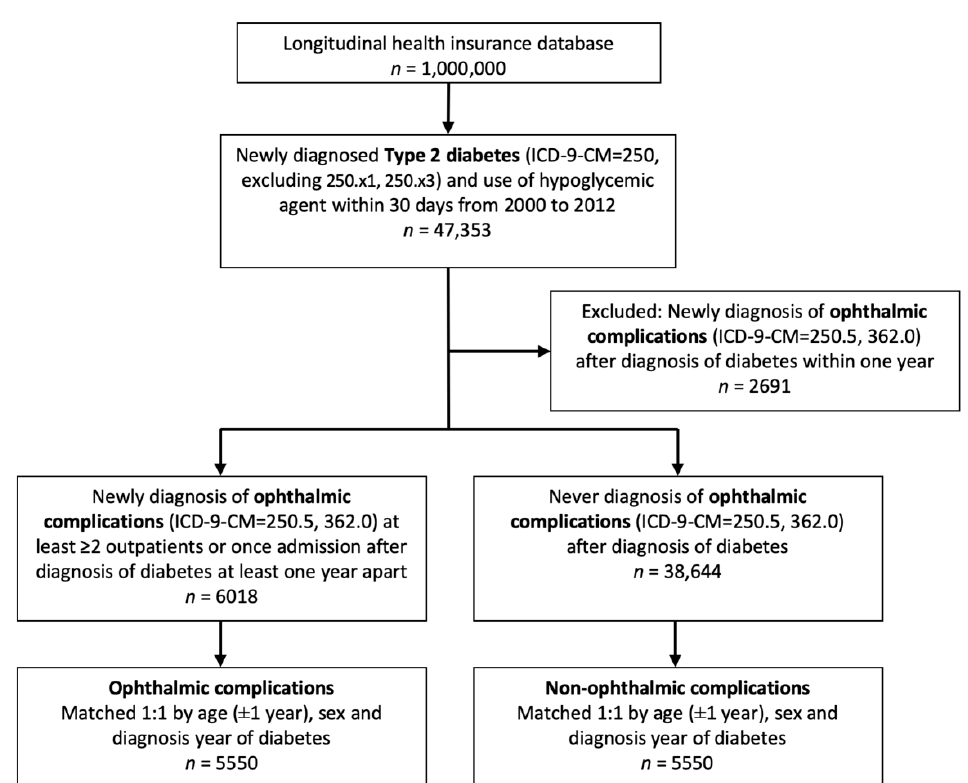
Figure 1. Flowchart of type 2 diabetes patient enrollment with and without ophthalmic complica- tions.